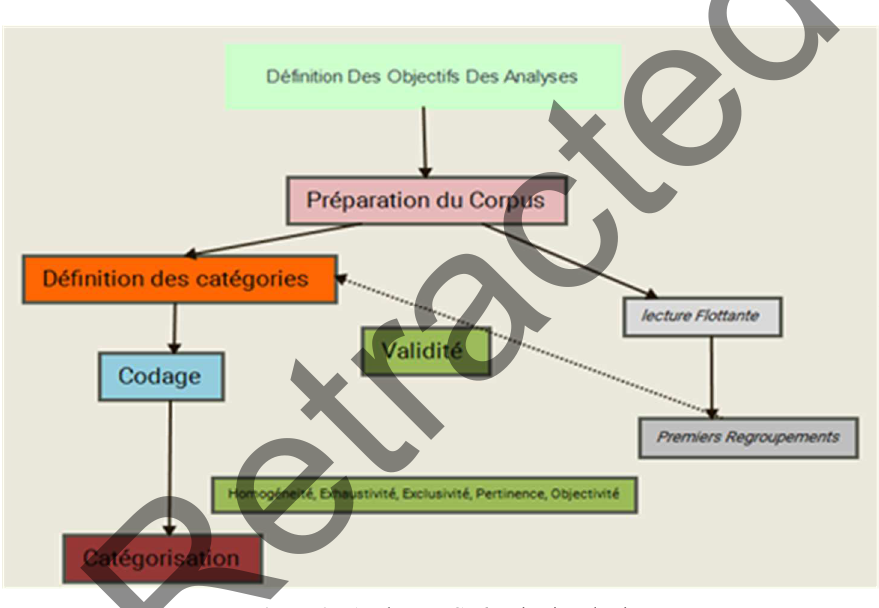
Figure 3 : Analyse et Catégorisation des